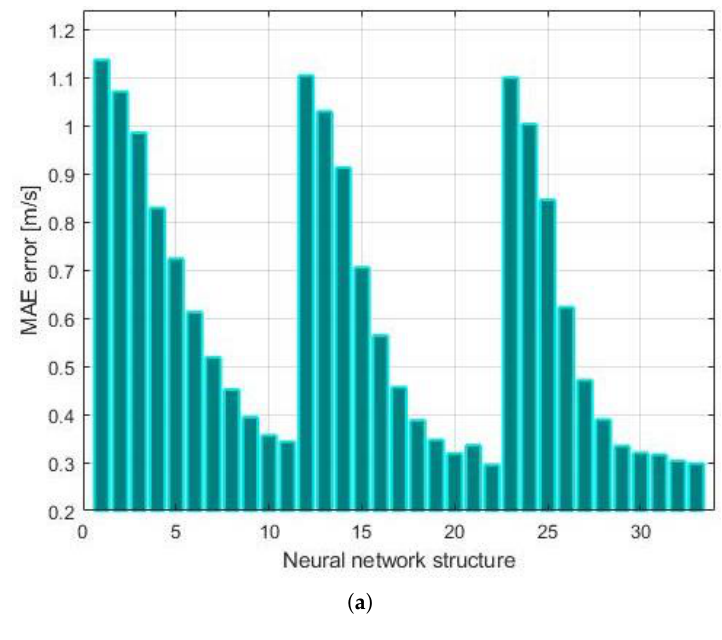
Number of Hidden Layers